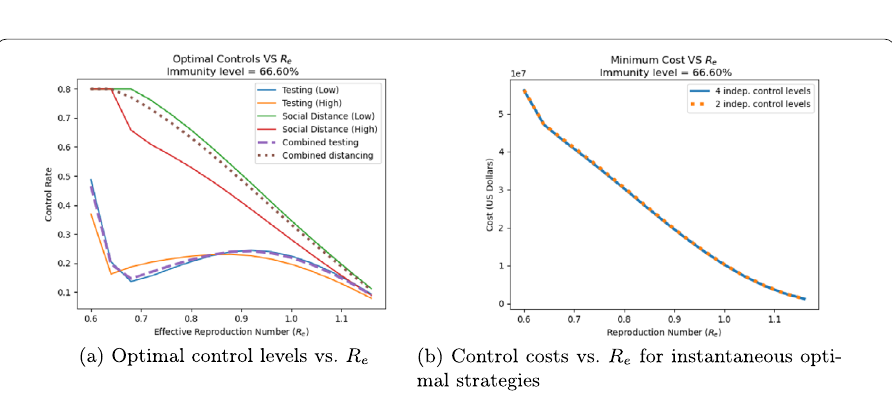
Figure 11 Optimal control levels ( a ) an associated control costs ( b ) as a function of population’s current R e value for populations with 0% immunity. Solid lines correspond to strategies in which both controls can be applied at different levels on the low-risk and high-risk population subgroups, while dashed lines are for strategies in which the same control levels are applied to both subgroups